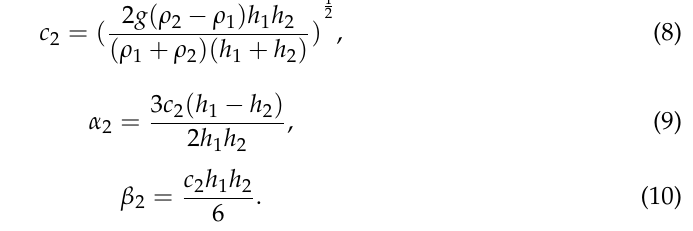
Figure 2. Vertical distribution of isopycnic lines of ISWs in a certain stratification ( a ) and experi ‐ mental method of calculating the amplitude and characteristic frequency of ISWs ( b ). 4. Results and Discussion To fully study the vertical structure characteristics of ISWs, four stratification condi ‐ tions were set in the experiment, and two types of ISWs (elevation ‐ and depression ‐ type) were generated during operation. The specific experimental conditions are summarized in Table 1. S1 is a representative of the stratification in the deep sea. S2–S4 are used to simulate the different stratifications in the continental shelves. Both elevation ‐ type ( 0  